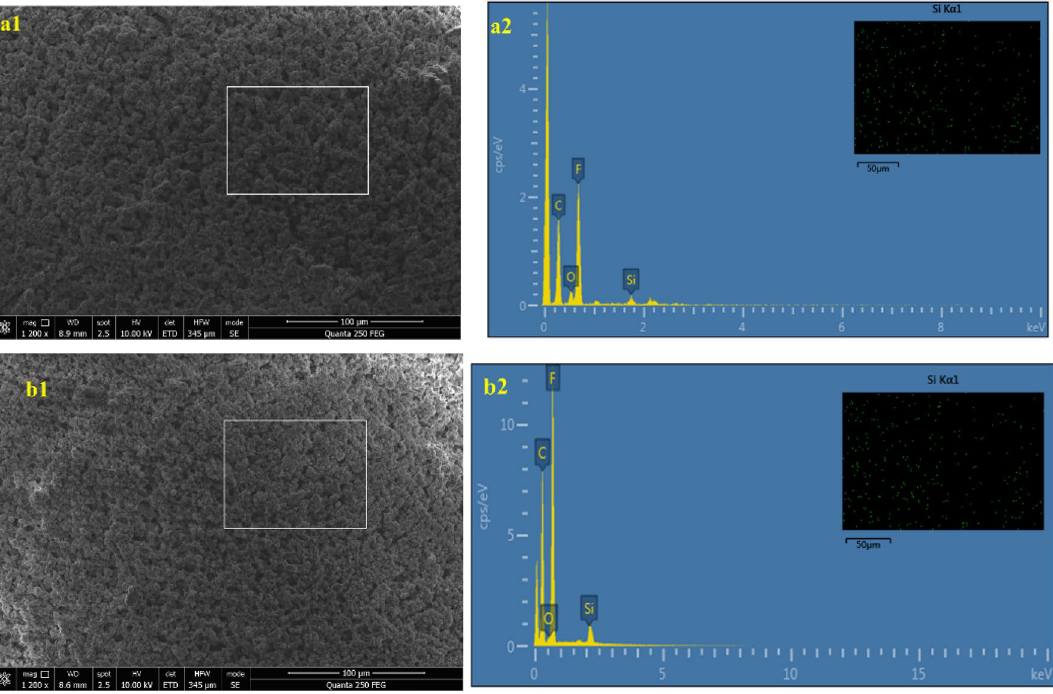
Figure 4. SEM images and the EDS spectrum and mapping (Si) of the membrane. ( a ) PVDF-SiO 2 -HDTMS membrane; ( b ) PVDF-HDTMS membrane; ( a1 ), ( b1 ) the outer surface image; ( a2 ), ( b2 ) EDS spectrum of the outer surface and EDS mapping for Si on outer surface.